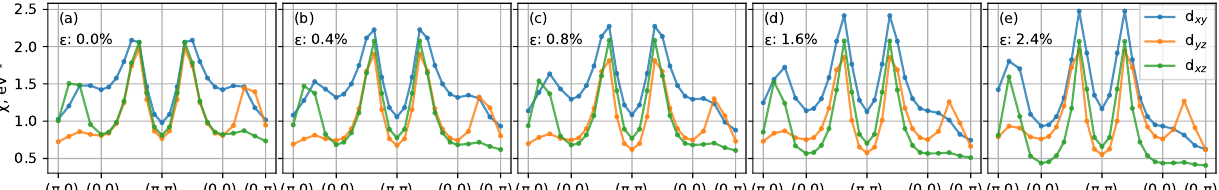
Figure 3. Orbital components of the real part of static spin susceptibility Re χ ( q , ω = 0 ) : ( a – e ) We orbitally resolve the static spin susceptibility along some high-symmetry directions of the Brillouin zone for different strains. The susceptibility at the ferromagnetic (FM) vector q FM = ( 0,0,0 ) , χ is dominated by the intra-orbital fluctuations in the d xy channel, while at the incommensurate (IC) vector q IC = ( 0.3,0.3, 0 ) (we use units 2 π / a throughout), the three orbitals contribute almost equally. The antiferromagnetic (AFM) vector q AFM = ( 0.5,0.5,0 ) is fully gapped. Under strain, the IC peak rapidly increases, and d xy emerges as the leading component of total spin susceptibilities along all high symmetry